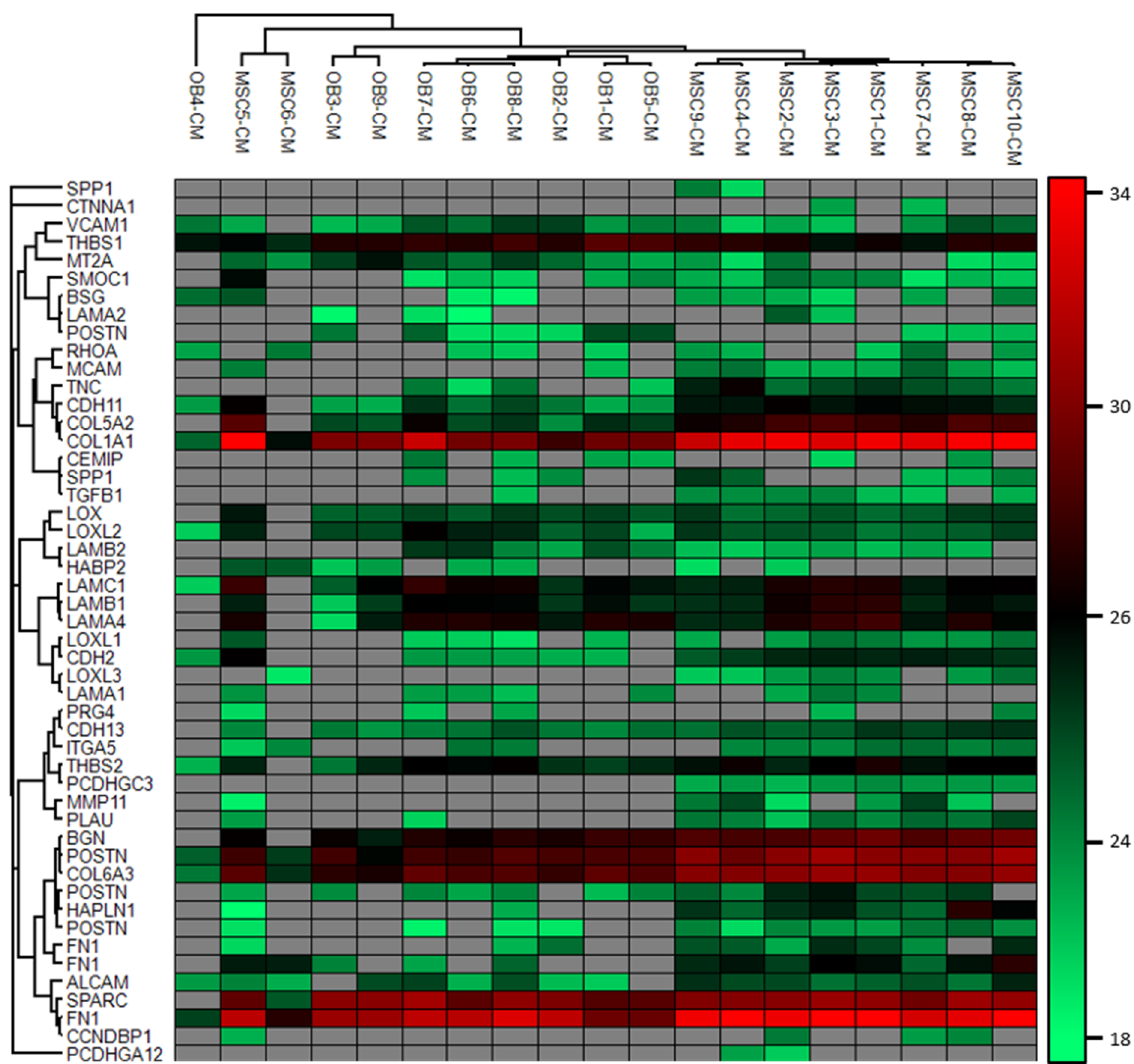
Figure 4. Hierarchical clustering analysis of proteins known to regulated bone marrow stem cell niches [1–5]. The analysis shows donor and cell type variation, i.e., protein intensity and detection of the proteins. Grey fields indicate that the protein was not detected in the donor conditioned medium. Most MSCs and OBs cluster together, but OB4, MSC5 and MSC6 differ from the others. In general, the most abundant proteins are THBS1, COL1A1, BGN, POSTN, COL6A3, SPARC and FN1, and particularly COL1A1, COL6A3 and POSTN1 are more abundant in MSCs. The cluster was generated using Pearson correlation as distance metrics and complete linkage of the protein matrix. The protein intensity is given as log2 LFQ intensity, and red indicates higher protein abundance. FN1, SPP1 and POSTN were detected as several isoforms and therefore represented several